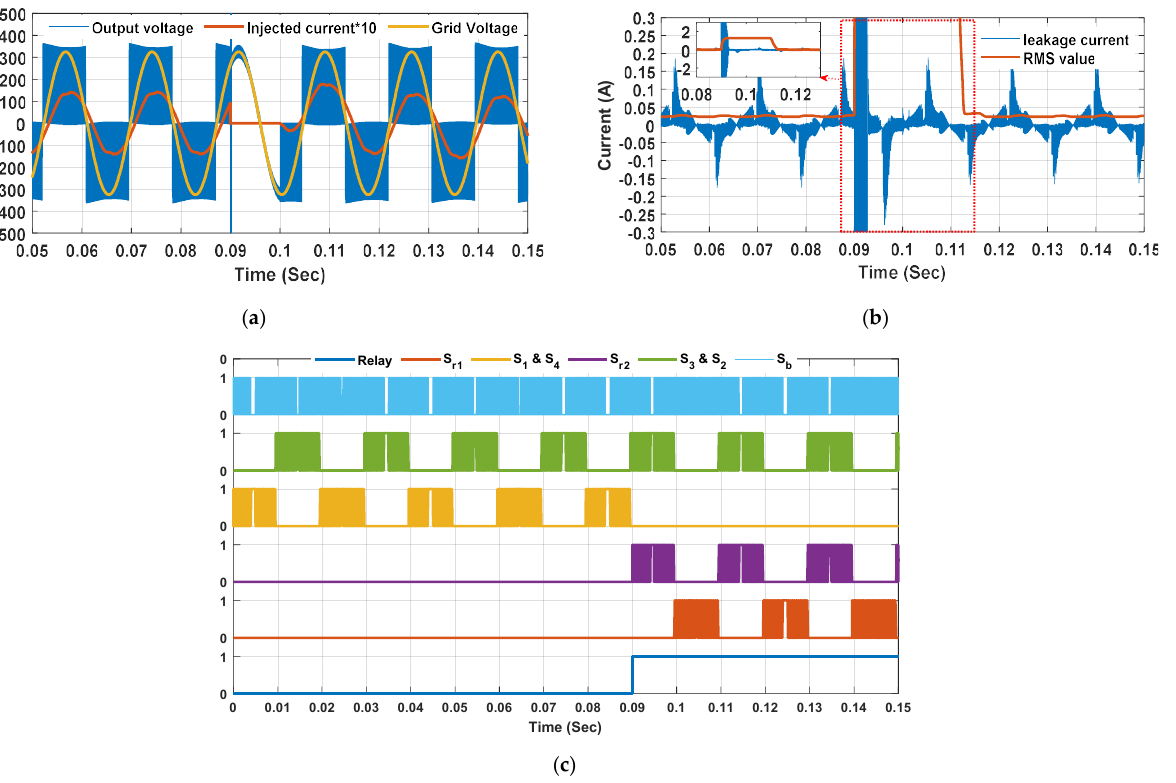
Figure 14. Performance when a fault occurs in one of the legs, ( a ) output voltage, injected current and grid voltage, ( b ) leakage current; and ( c ) switching and relay signals.